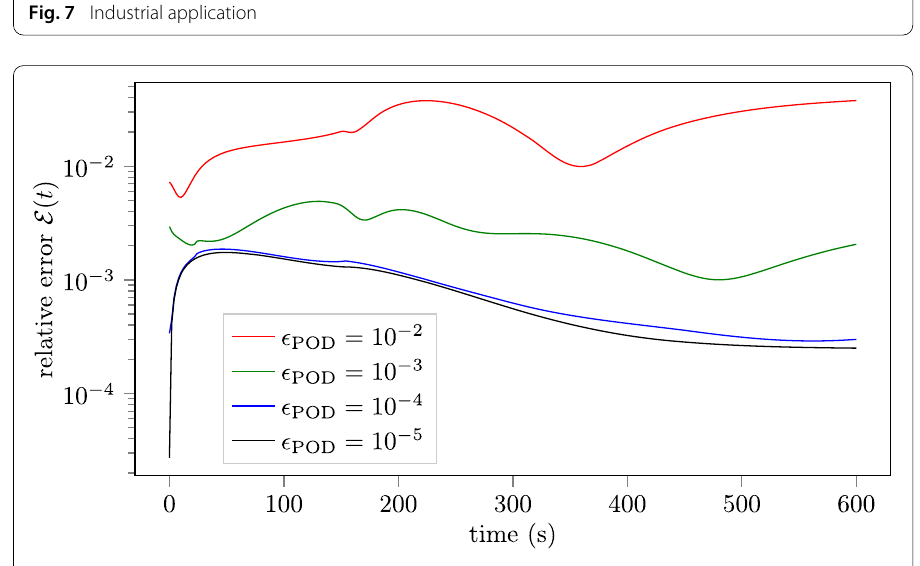
Fig. 8 Industrial application. Time-dependent relative error E ( t ) with respect to time for various values of (cid:8)